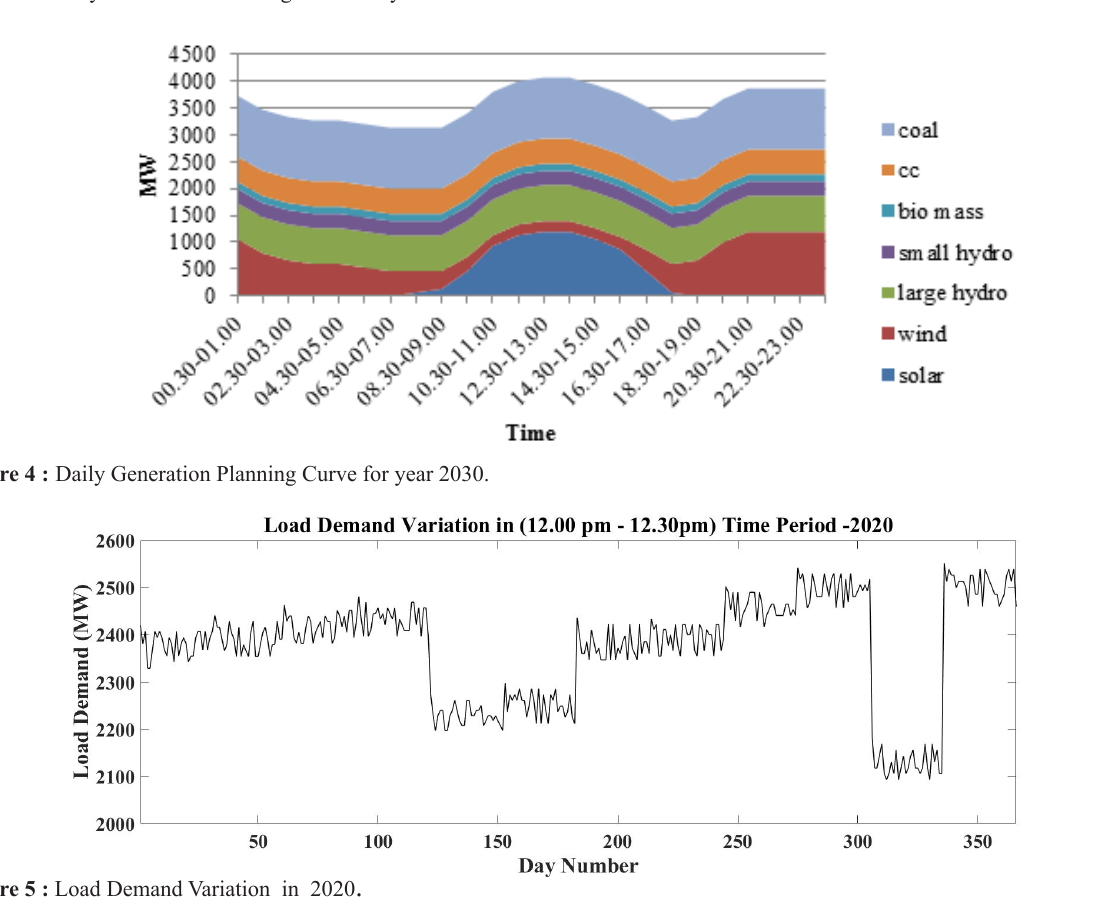
Figure 3: Daily Generation Planning Curve for year 2020.